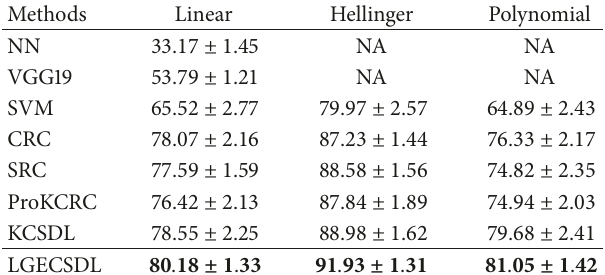
Table 1: Recognition rate on the Extended YaleB database (%).